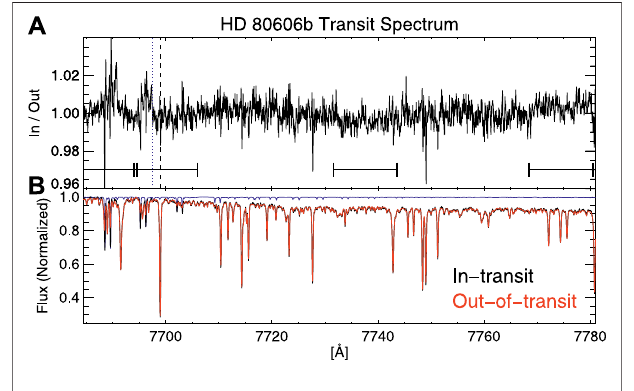
FIGURE 3 | (B) Keck HIRES spectra of HD 80606 timed in (black) and out(red)oftheHD80606btransit.Peak fl uxhasbeennormalizedtounity.The blue spectrum shows the telluric transmission model in-transit. OSIRIS tunable fi lter bandwidths sampled by Colón et al. (2012) are shown as black bars. (A) : ratio of in/out of transit. Dashed black and dotted blue lines indicate ofthestellar and planetary potassium Dwavelengths, respectively (as in Figure 2 ).